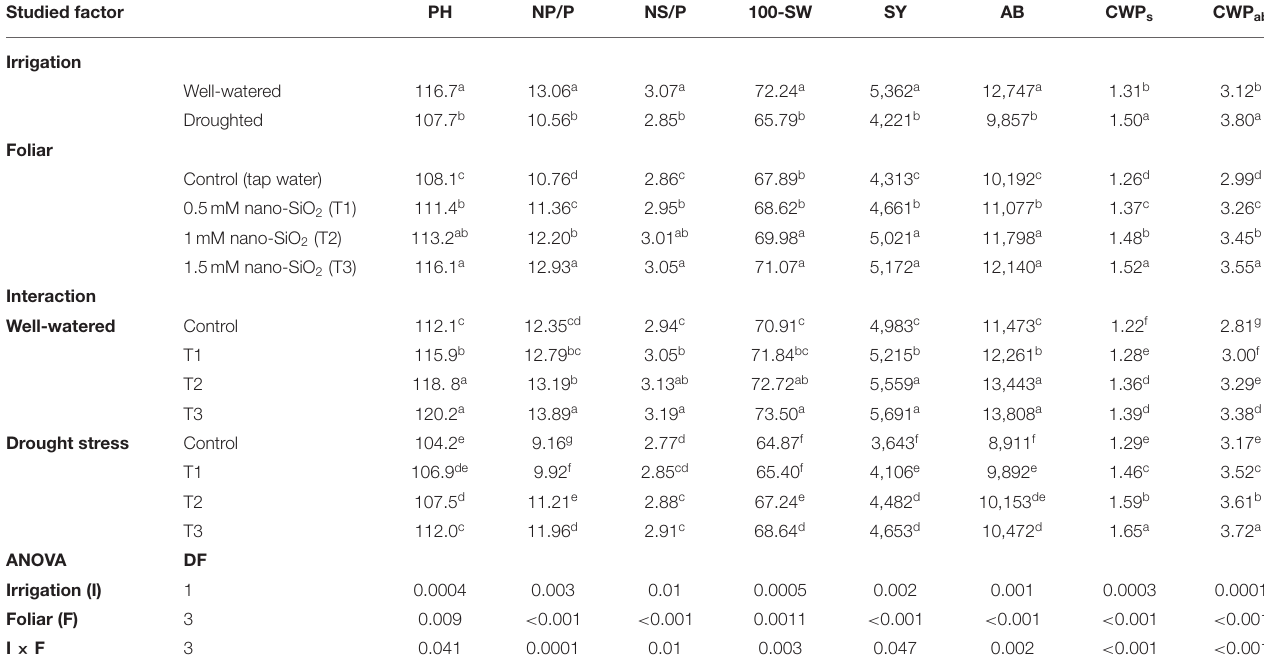
TABLE 1 | Impacts of nano-silicon dioxide (nano-SiO 2 ) foliar application on Vicia faba plant height (PH, cm), number of pods plant − 1 (NP/P), number of seeds pod − 1 (NS/P), 100-seed weight (100-SW, g), seed yield (SY, kg ha − 1 ), aboveground biomass (AB, Kg ha − 1 ), crop water productivity (kg m − 3 ) for seed yield (CWP s ), and aboveground biomass (CWP ab